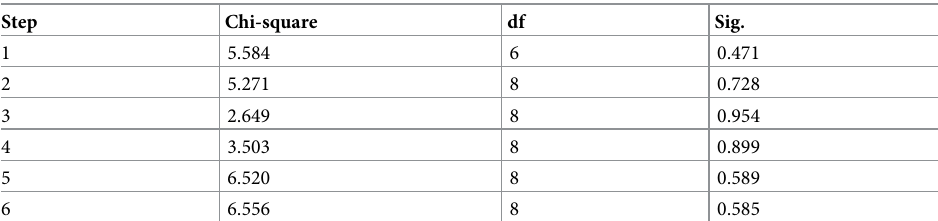
Table 5. Hosmer and Lemeshow